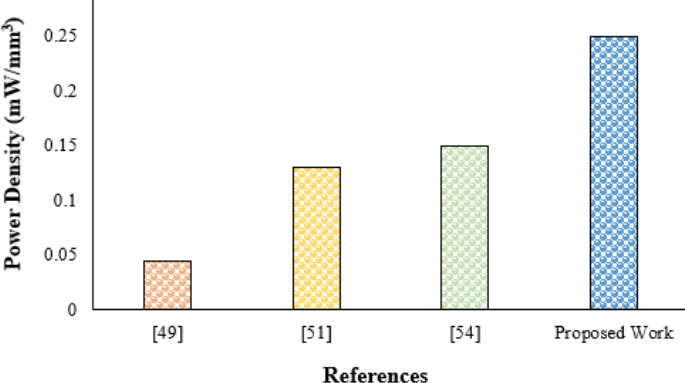
Figure 15. Comparison of harvested energy in terms of power density.